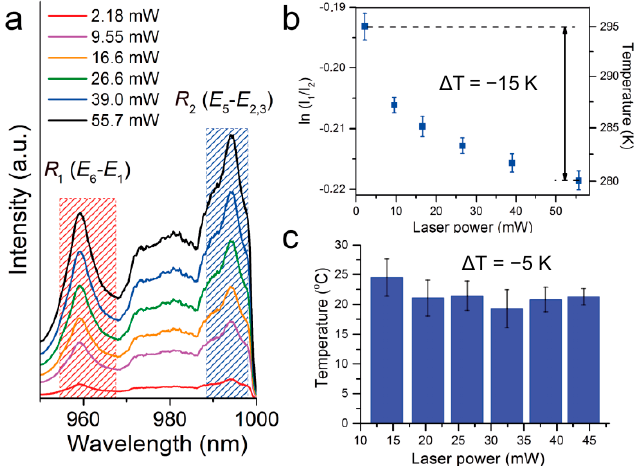
Figure 3. Laser cooling of Yb:LLF crystals. ( a ) PL spectra of the Yb:LLF crystal on a SiO 2 optical fiber in air under 1020 nm diode laser excitation measured at different irradiances. ( b ) Cryostat calibration of PL spectra of the Yb:LLF crystal on a SiO 2 optical fiber in air under 1020 nm diode laser excitation measured at different irradiances. ( c ) Laser refrigeration of the Yb:LLF crystal in deionized water measured via cold Brownian motion analysis at different irradiances.